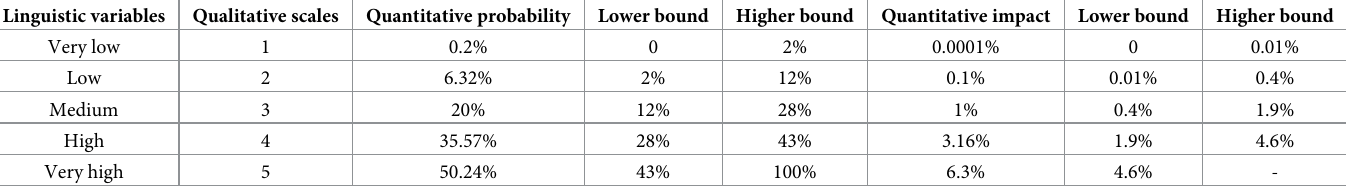
Table 3. Five-point logarithmic value and